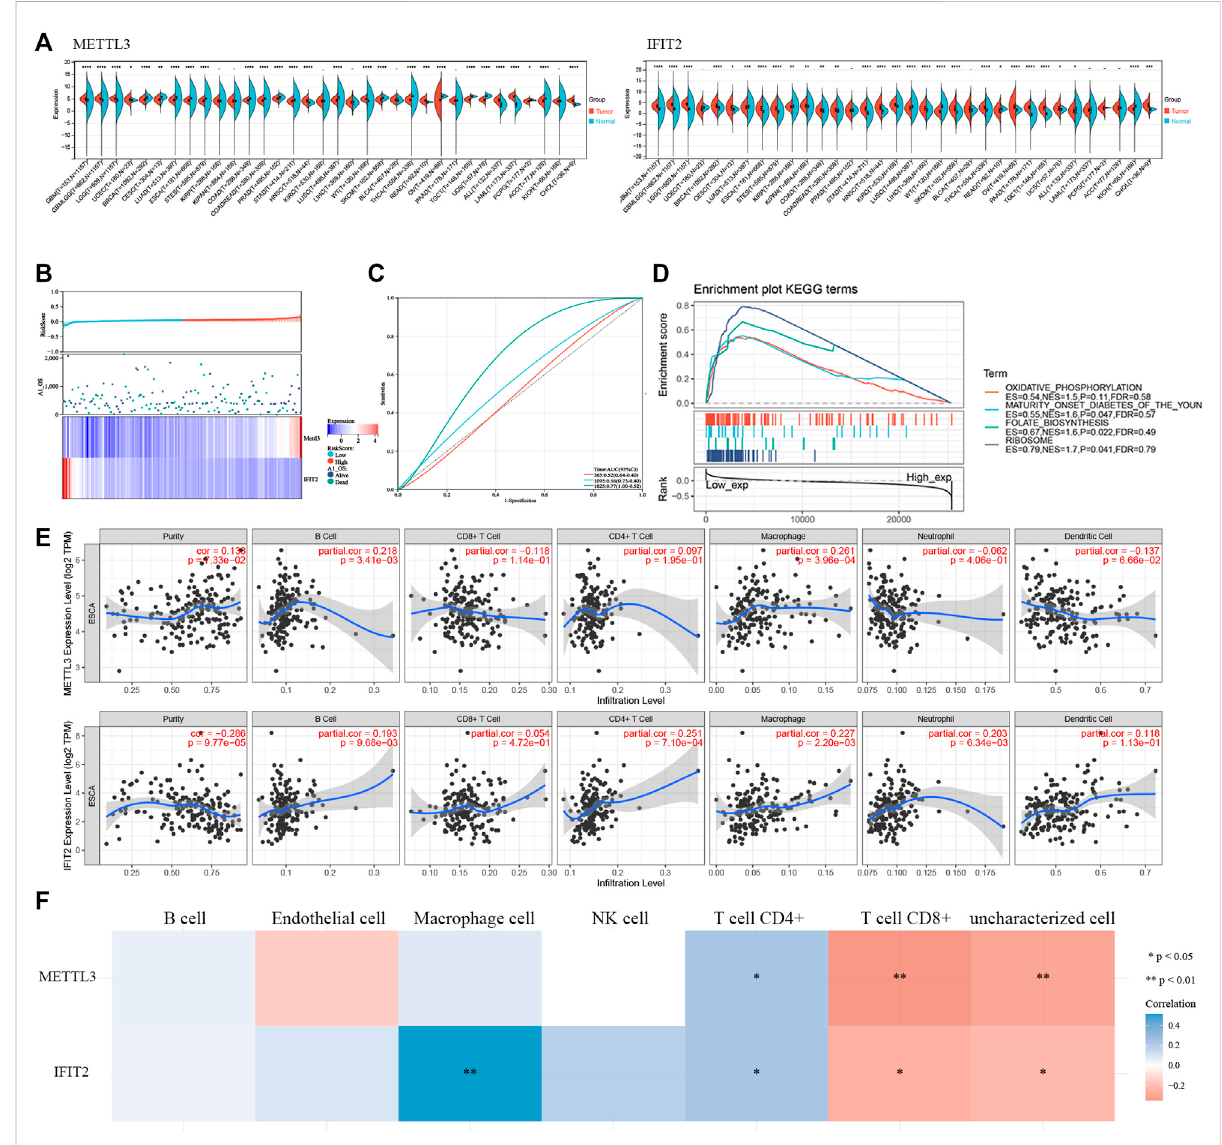
METTL3 and IFIT2 are associated with prognostic immune in fi ltration (A) . Pancancer analysis of METTL3 and IFIT2 expression across cancers from TCGA. (B) . The expression pro fi les that correspond to the distributions of prognostic signature-based risk scores. Low-risk patients are represented by green dots, while high-risk patients are represented by red dots. (C) . The ROC curve for evaluating the prediction ef fi ciency of the prognostic signature. (D) . Correlation of IFIT2 gene expression and pathway enrichment in TCGA esophageal cancer samples by GSEA enrichment analysis. (E) . Correlation of IFIT2 and METTL3 expression levels with immune in fi ltration of B cells, CD4 T cells, CD8 T cells, neutrophils, macrophages, and dendritic cells in ESCC. (F) . A heatmap of the correlation between METTL3, IFIT2 and immune